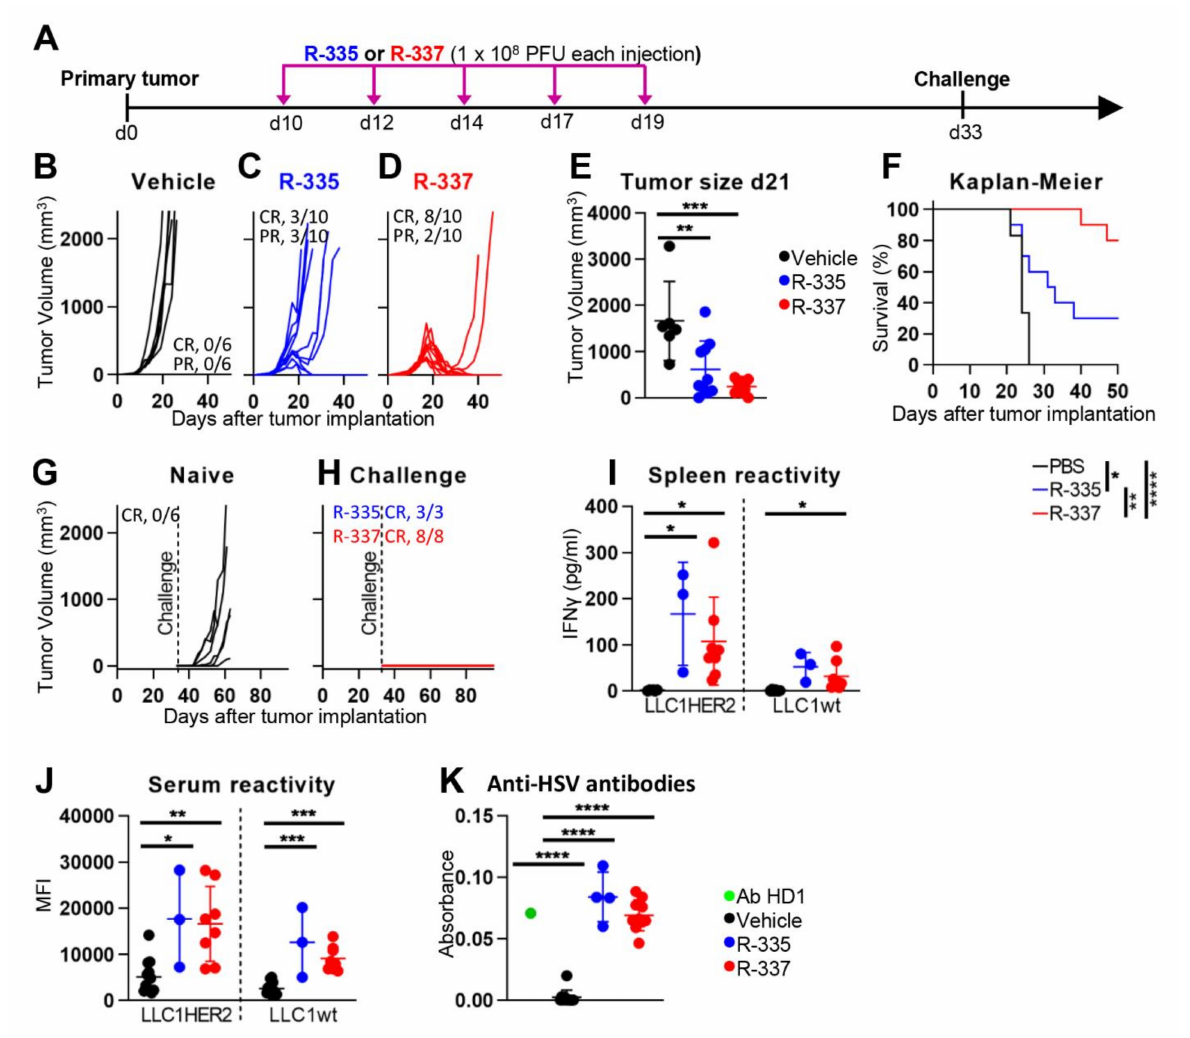
Figure 4. Efficacy of R-335 and R-337 monotherapy on the growth of LLC-1-HER2 tumors. ( A ) Schedule of treatments. The six-to-eight weeks old HER2-transgenic/tolerant (HER2-TG) C57BL/6 mice were subcutaneously implanted in the left flank with 5 × 10 5 LLC-1-HER2 cells in 100 µ L of PBS [55]. 10 d later, when the tumor volumes averaged 70–100 mm 3 ,